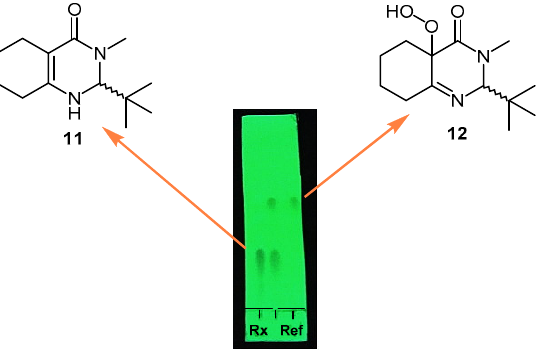
Figure 5 . Thin layer chromatography (hexane:AcOEt, 8:2) of Rx) in N 2 atmosphere and without light; Figure 5. Thin layer chromatography (hexane:AcOEt, 8:2) of (Rx) in N 2 atmosphere and without light; compound 12 for reference. compound 12 for